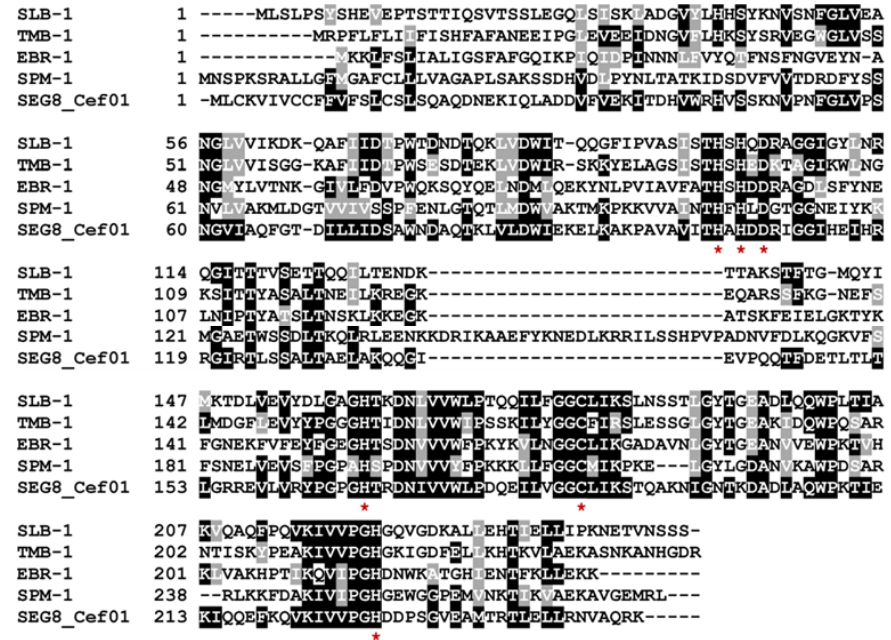
tained all zinc-binding amino acids typical for subclass B1 (Figure 3).